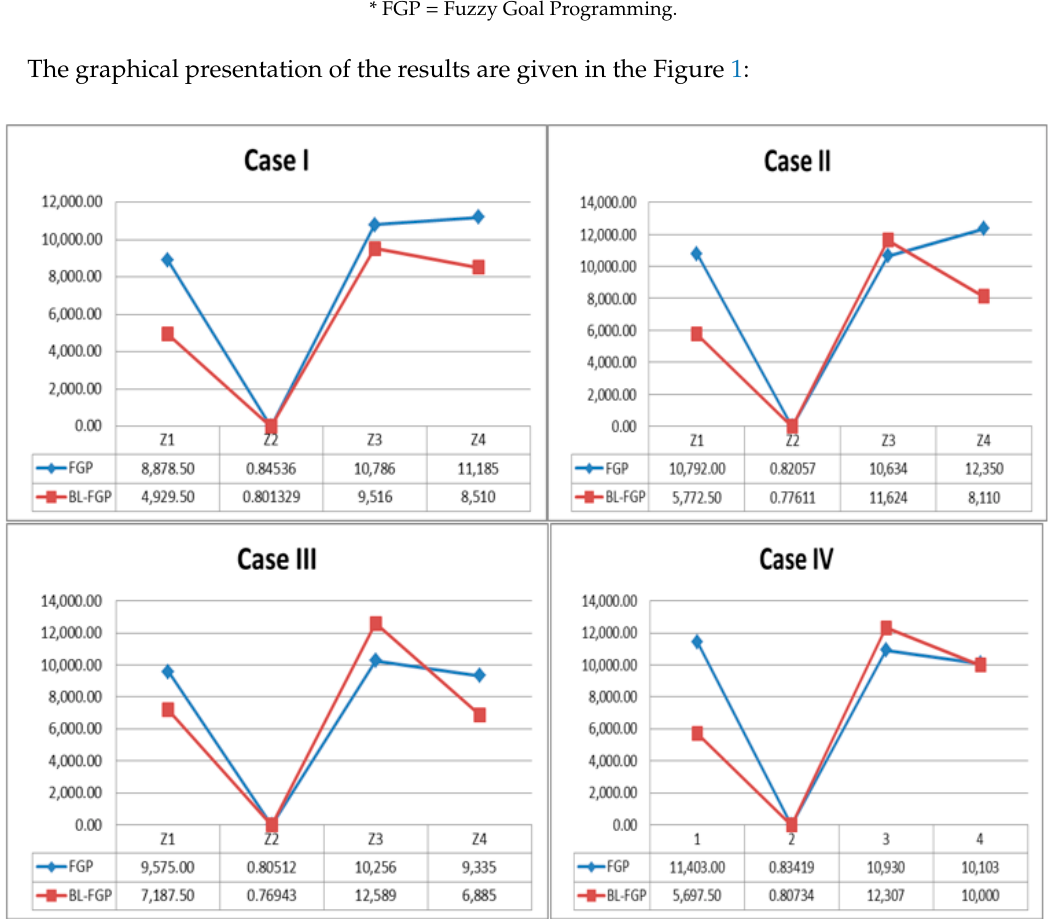
Table 3. A compromise solution to the problem.